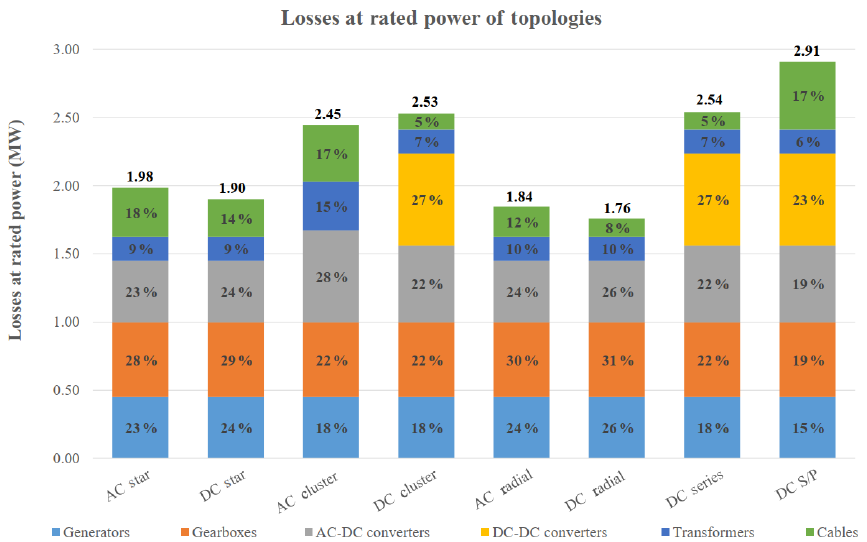
Figure 13. Total losses at rated power of electrical topologies with breakdown by